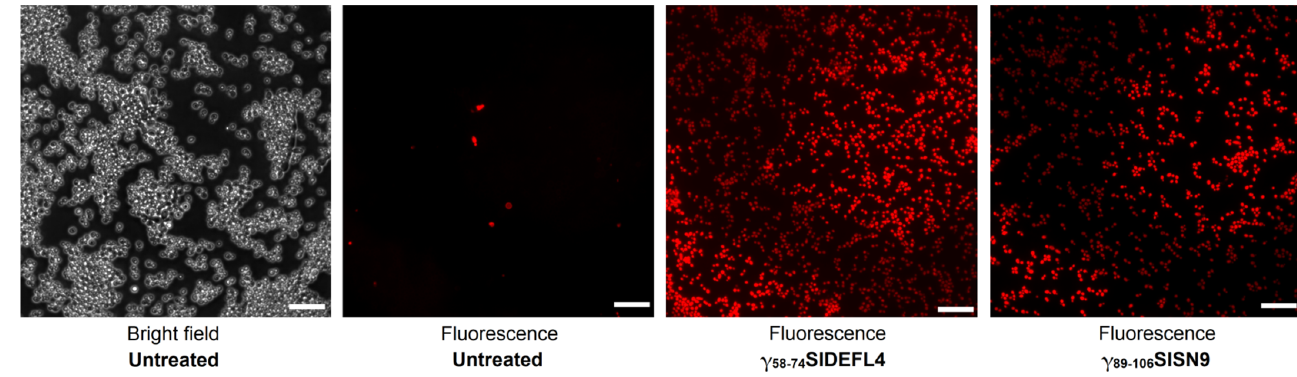
Figure 6. Images of C. albicans cells incubated in the presence of 300 µM of γ 58-74 SlDEFL4 and γ 89-106 SlSN9 peptides for 1 h and stained with propidium iodide. Untreated C. albicans cells were used as negative control. Scale bar = 20 µm.